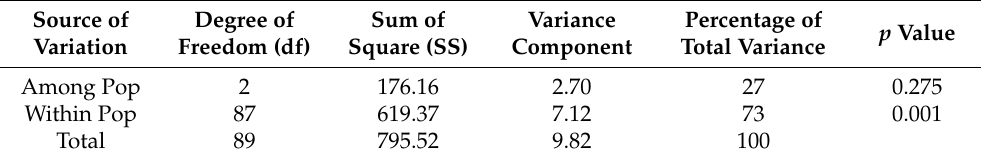
Table 4. Analysis of molecular variance (AMOVA) based on SSR marker among 90 accessions of cultivated and weedy types of the Perilla crop collected from South Korea. Source